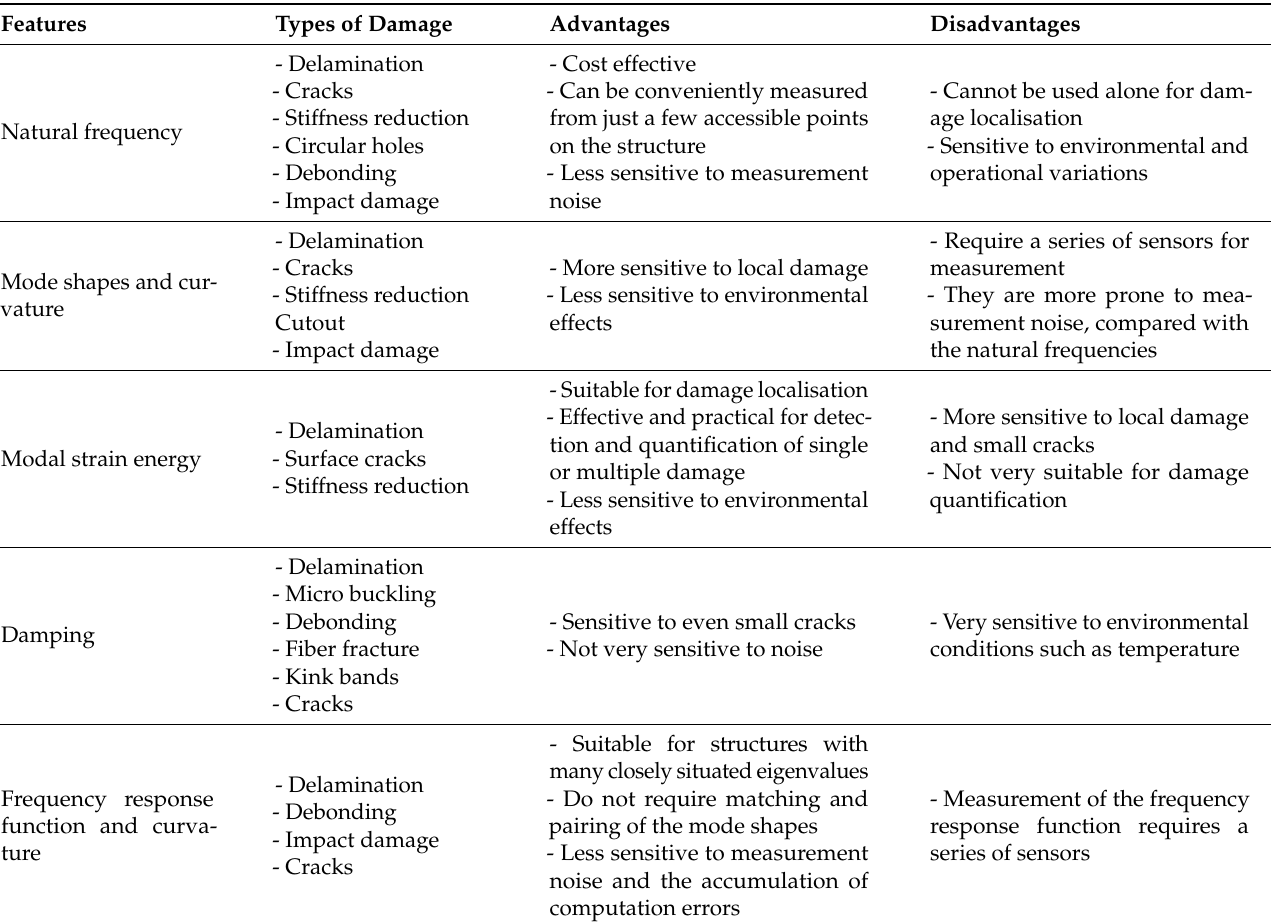
Table 9. Characteristics of different modal data employed for damage detection of composite